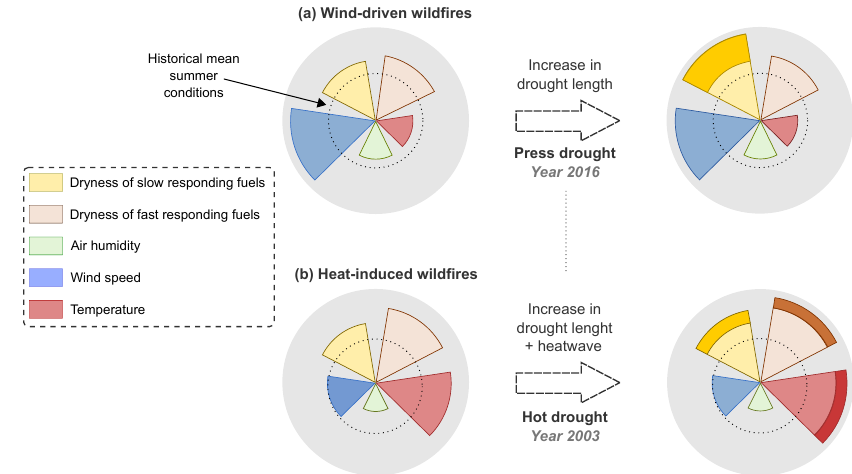
Figure 9. Schematic representation of the changes on fire weather induced by global-change-type droughts and that are expected to increase the frequency of extreme wildfire events in the northern Mediterranean. Two distinct shifts in the meteorological fire niche resulted from specific combinations between the types of droughts and fire weather types (FWTs). Each grey circle represents the daily weather and drought conditions associated with fire occurrence. The inner circle represents the historical mean summer daily values. Each slice represents the anomaly of the corresponding variables compared to the mean daily summer values. Panel (a) shows the modification of the wind-driven FWTs with press droughts as illustrated by the 2016 fire season. Panel (b) shows the modification of the heat-induced FWTs with hot droughts as illustrated by the 2003 fire